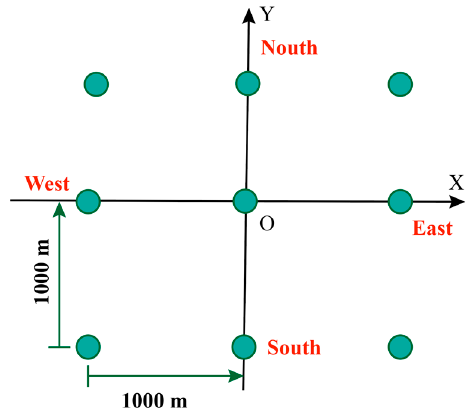
Figure 9. Simulation scene.